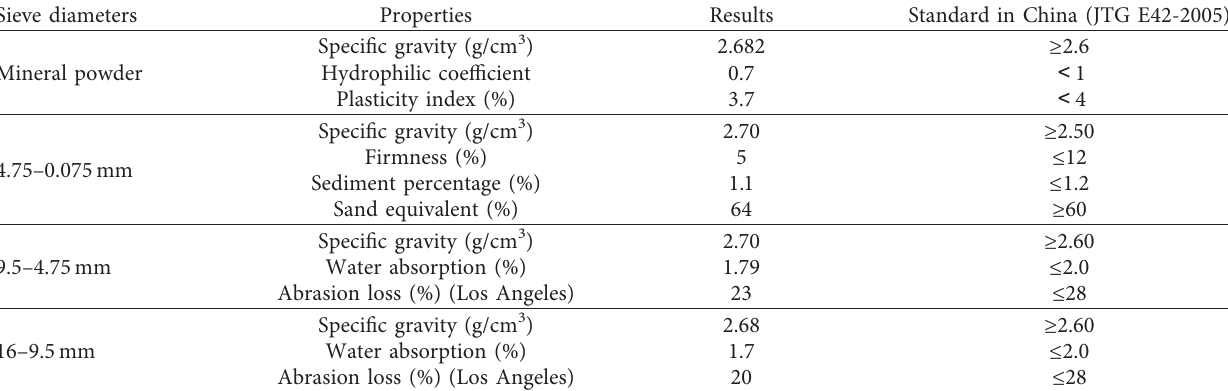
Table 2: Properties of the aggregate used in the study.